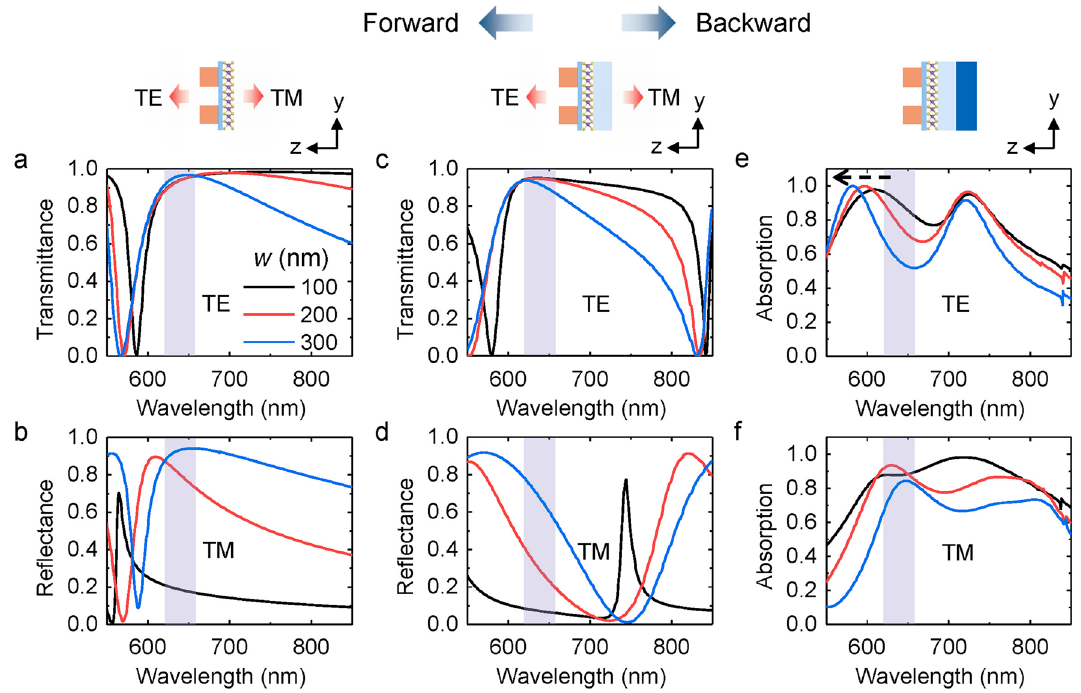
Figure 5. Polarization resolved spectra as a function of the wire width by simulations. ( a )–( b ) Transmittance of the TE polarized light and reflectance of the TM polarized light under the forward incidence for the nanowire array on Al 2 O 3 substrate with p = 600 nm, w = 100, 200, 300 nm respectively. ( c )–( d ) The corresponding spectra of the nanowire array on